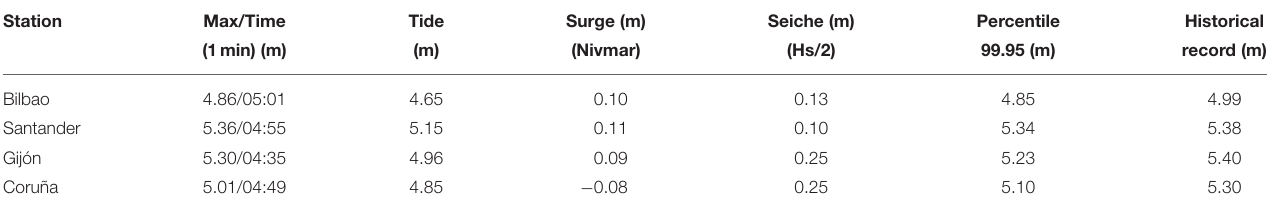
TABLE 1 | Column 2: extreme total sea levels (m) / time (hh:mm GMT) recorded the 2nd of February by the tide gauges of Bilbao, Santander, Gijón and Coruña (sampling interval: 1min); columns 3–5: contribution of the tide, surge and high frequency oscillation (considered here as half the significant wave height), the two latter at 05:00 GMT; columns 6 and 7: 99.95 percentile, and maximum sea level of the historical record (1992 to present).